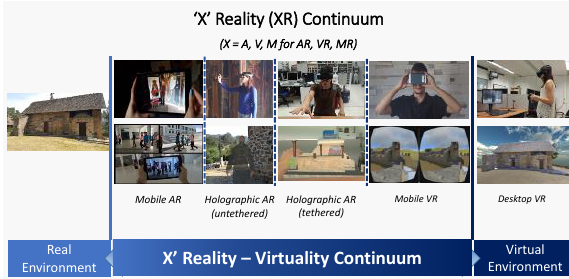
Figure 1. Extended Reality (X-Reality or XR) taxonomy